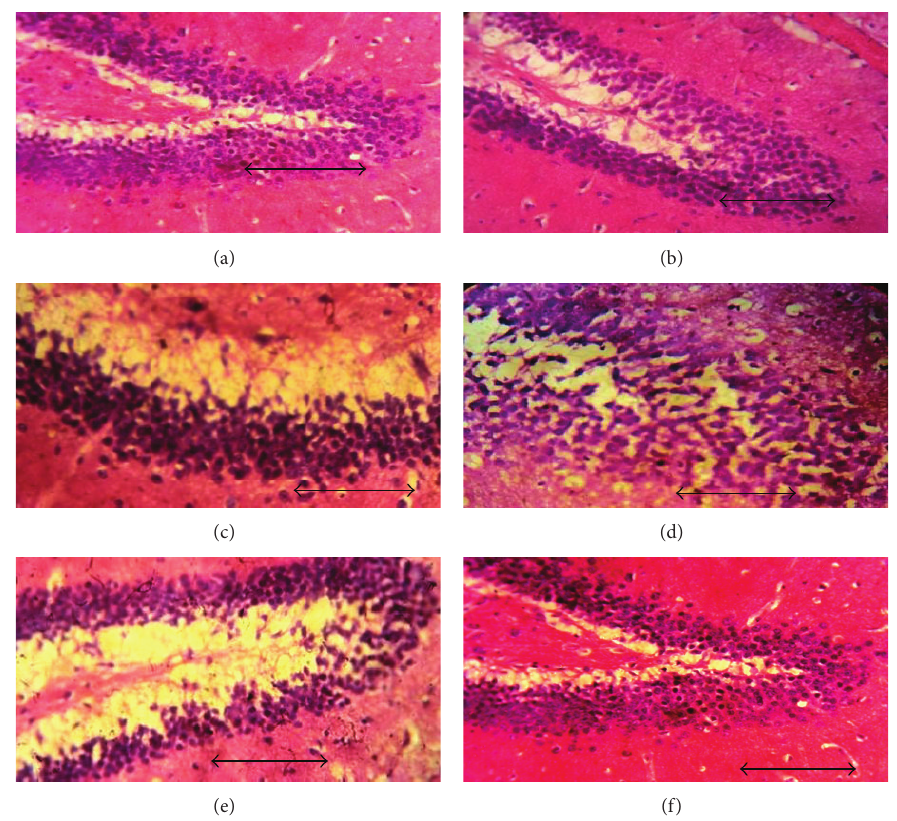
Figure 5: Effect of lisinopril and fosinopril on the morphology of dentate gyrus region of hippocampus in scopolamine-induced amnesic rats. Light photomicrographs of dentate gyrus layer of hippocampus in (a) control rats, (b) scopolamine, (c) lisinopril (0.225 mg/kg) + scop., (d) lisinopril (0.45 mg/kg) + scop., (e) fosinopril (0.90mg/kg) + scop., and (f) fosinopril (1.80 mg/kg) + scop. Scale bar represents 1 𝜇 .